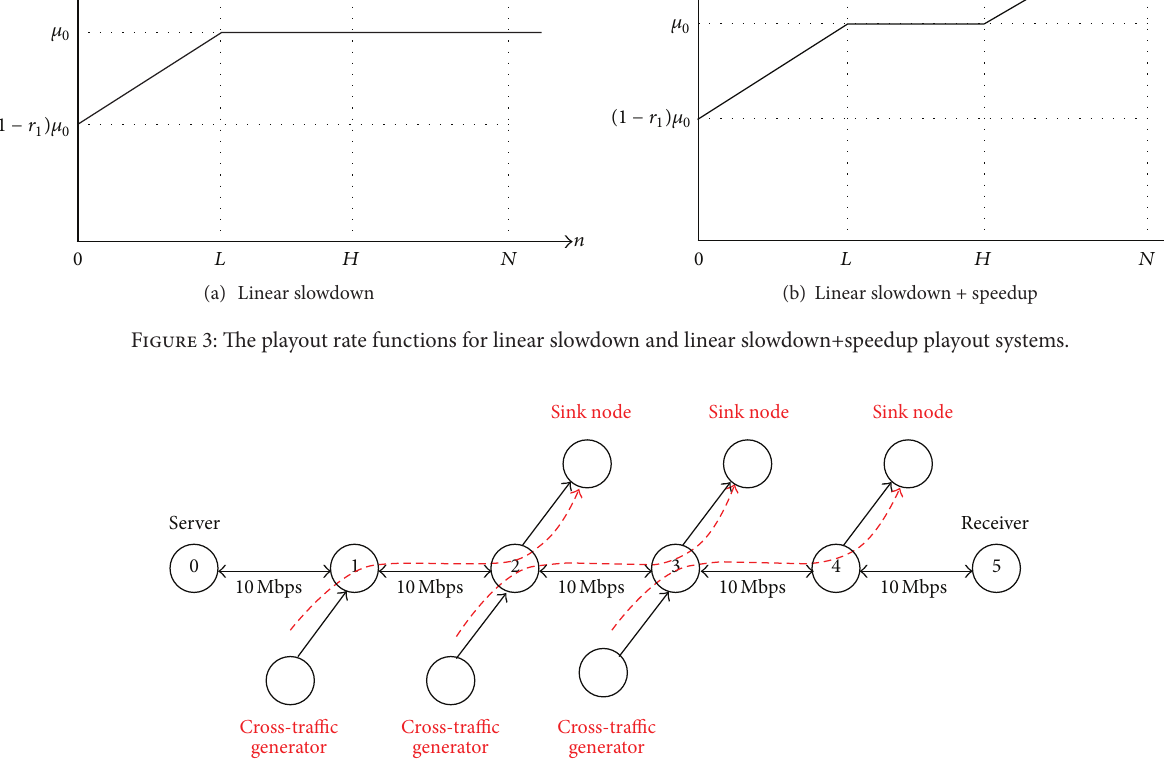
Figure 4: The network architecture for generating jittered video traffic patterns.